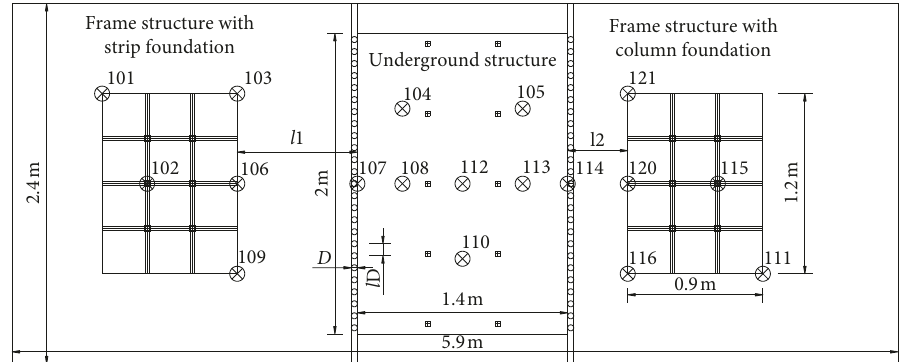
Figure 7: The position plan of soil pressure sensors.